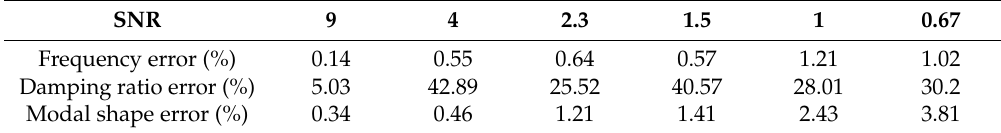
Table 1. Identification error of ACS-SSI under different signal-to-noise ratios (SNRs).